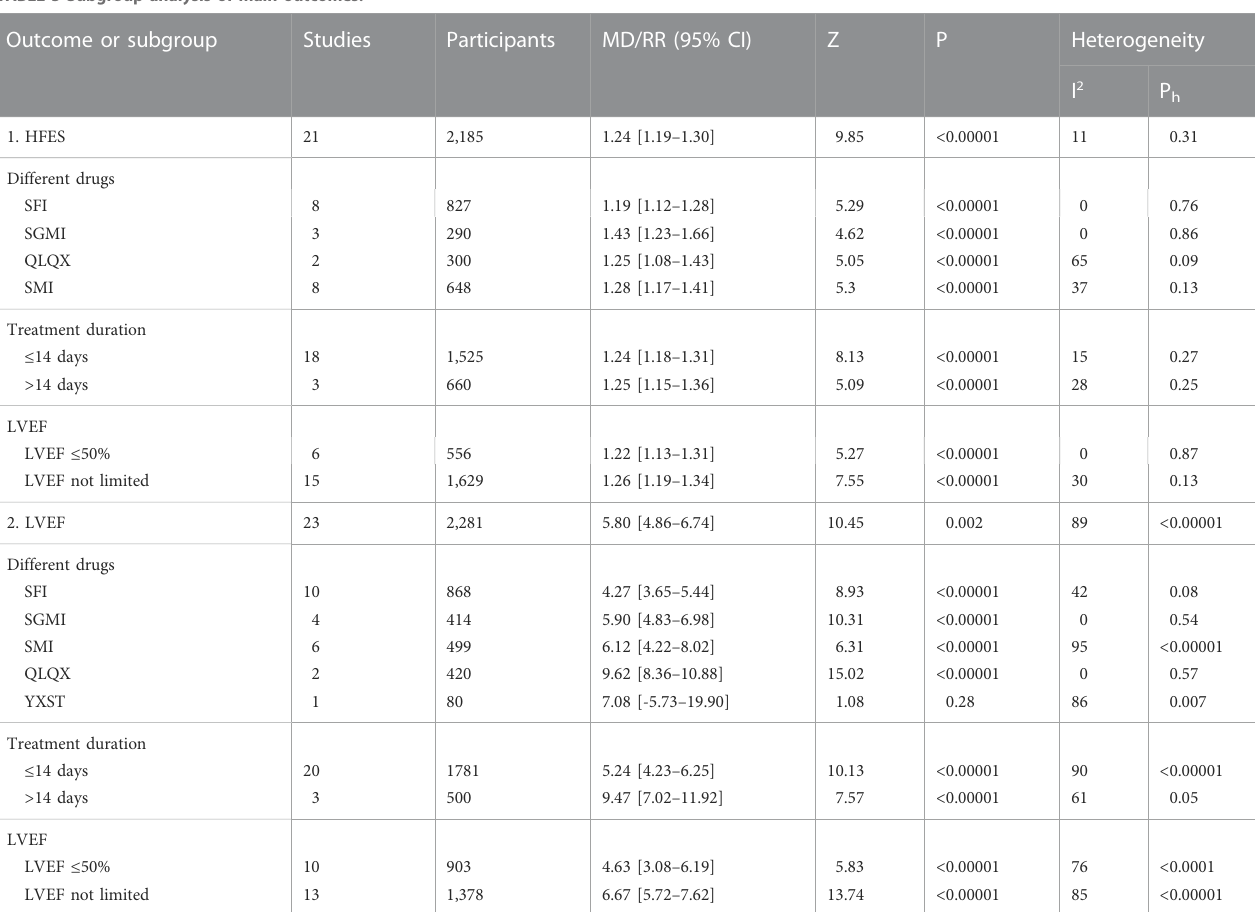
TABLE 5 Subgroup analysis of main